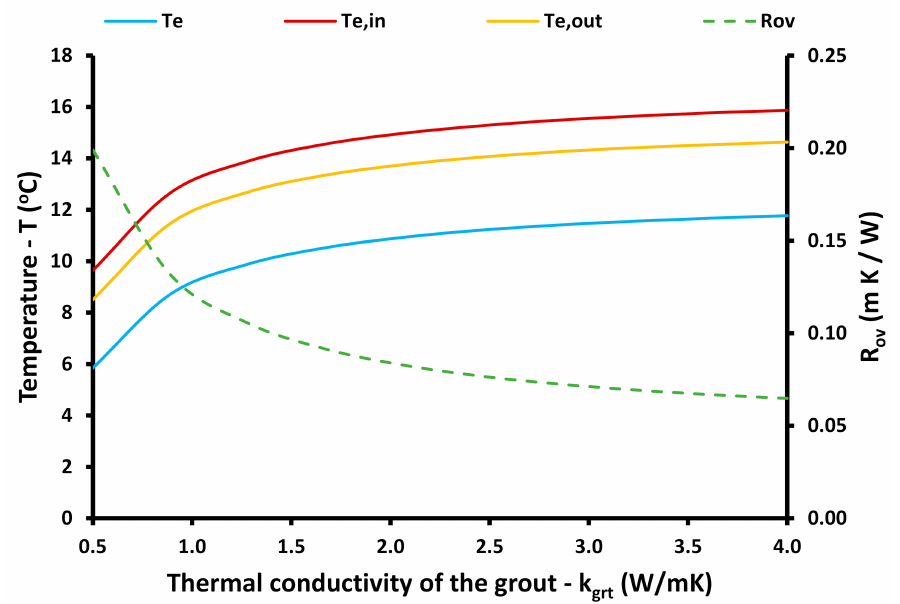
Figure 17. The impact of the grout thermal conductivity on the evaporator temperature levels and on the overall